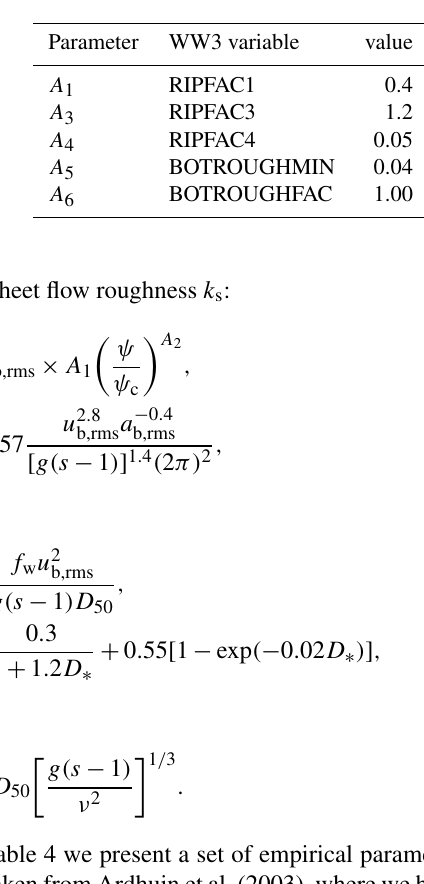
Table 4. List of empirical parameters used in SHOWEX bottom friction parameterization. The WW3 variables’ names correspond to the keyword used in the model’s BT4